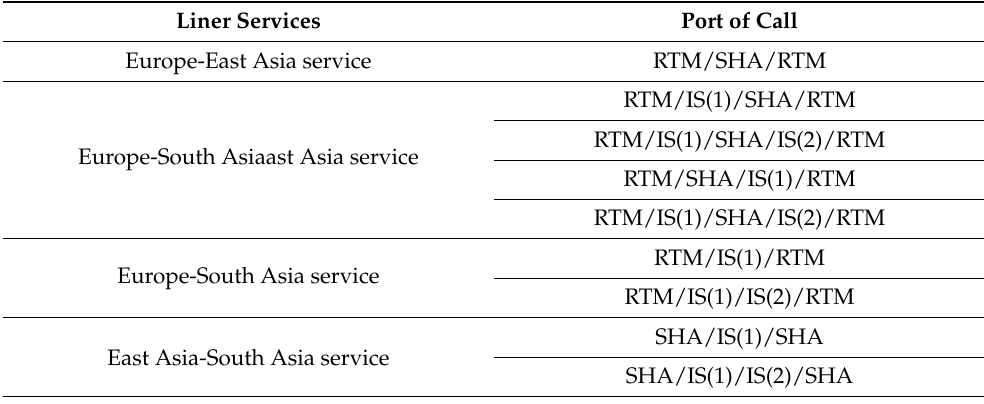
Table 2. Research target services. Liner